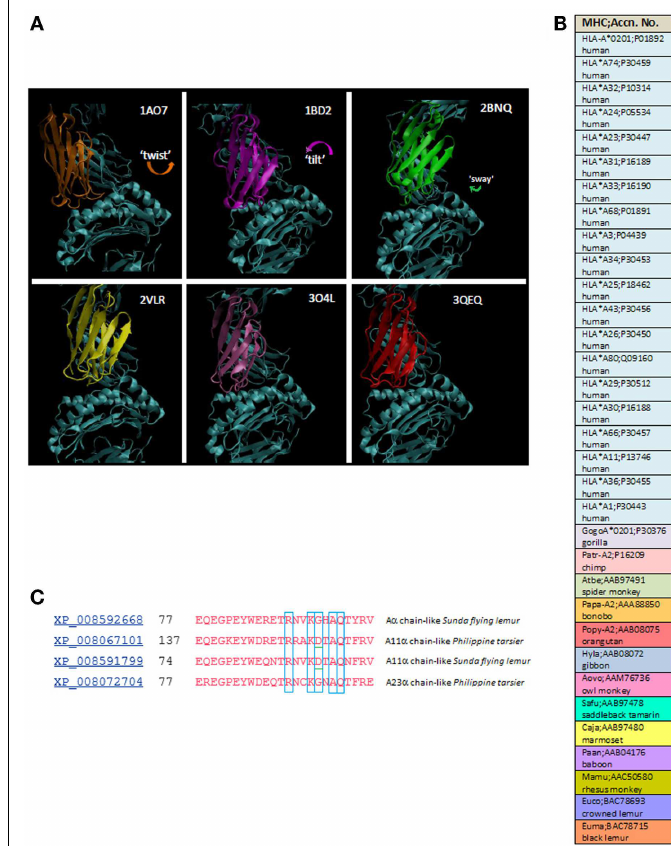
the R65 motif and CDR2 α -contact region among HLA-A alleles and non-human primate MHC A-like proteins. Sequences are from NCBI ( blink analysis) with the HLA-A*0201 sequence as query (www.ncbi.nlm.nih.gov). (C) NCBI ( blast ) of HLA-A2 against prosimians taxid; alignment of different alleles (see